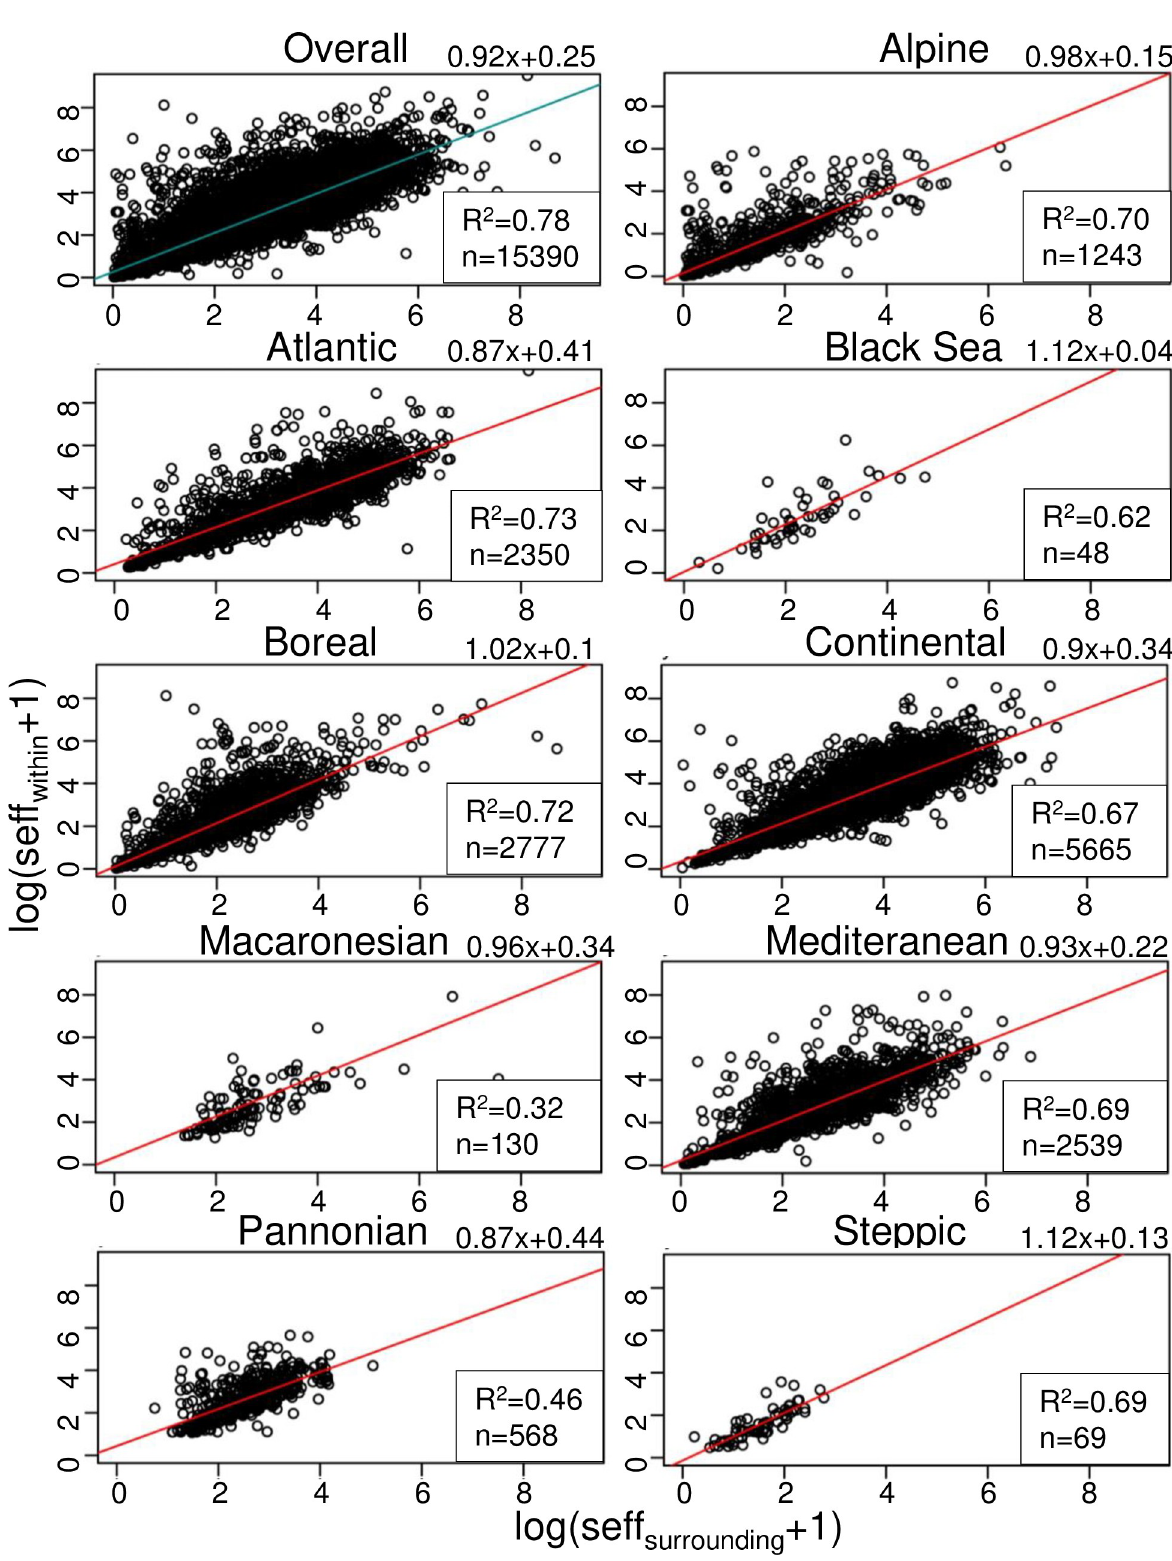
Fig 7. Correlation between effective mesh density ( seff ) within and around N2k sites for the nine biogeographical regions of the EU. seff significantly correlates with seff surrounding for all nine biogeographical regions. For each biogeographical region, the R 2 value, the number of sites ( n ), and the linear regression formula with x = seff are provided. surrounding https://doi.org/10.1371/journal.pone.0258615.g007 PLOS ONE | https://doi.org/10.1371/journal.pone.0258615 October 21,